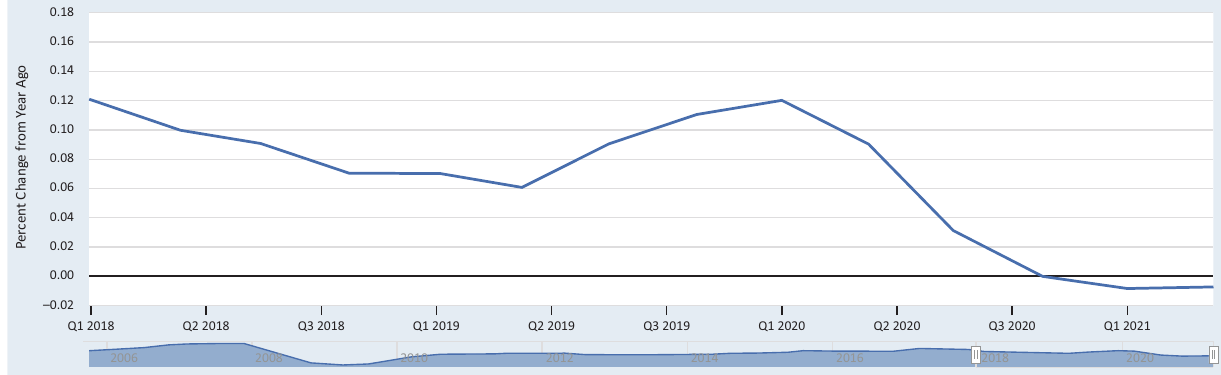
Figure 9. Commercial real estate prices for Australia, Q1 2018–Q1 2021. Source: International Monetary Fund, retrieved from Federal Reserve Bank of St. Louis